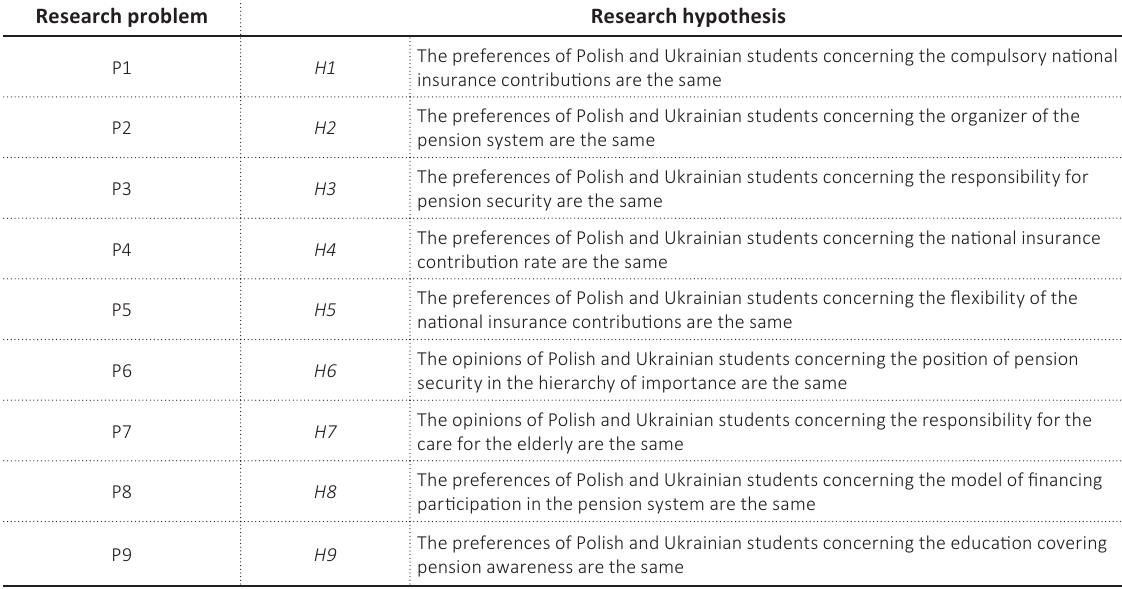
Table 3. The research hypotheses concerning Polish and Ukrainian students’ preferences in terms of the selected aspects of the pension security